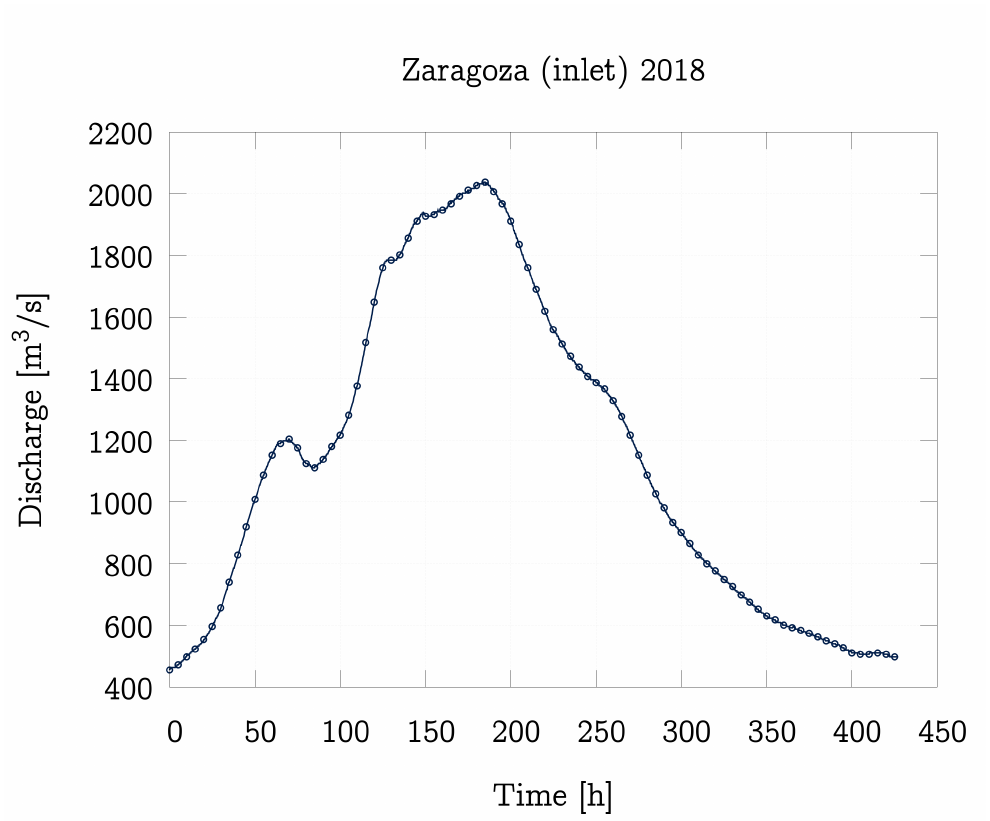
Figure 9. Inlet hydrographs for the Ebro River flood event in 2018 in Zaragoza (A011).